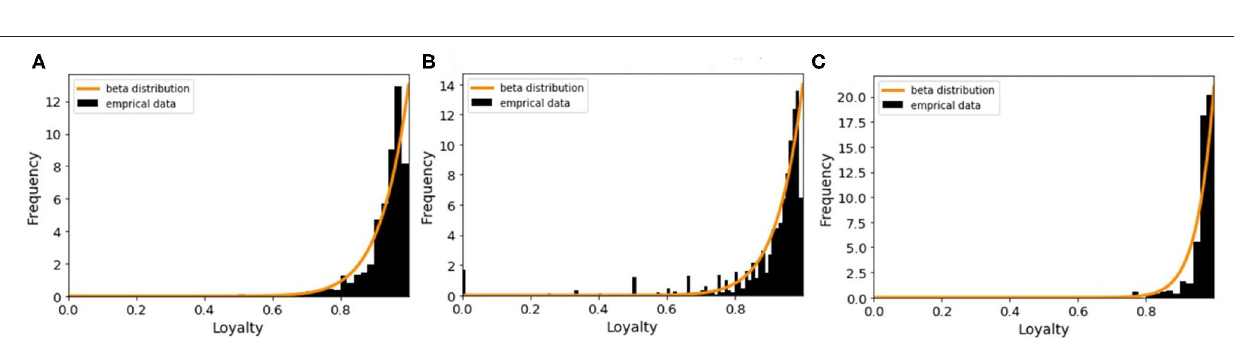
generated networks (%)